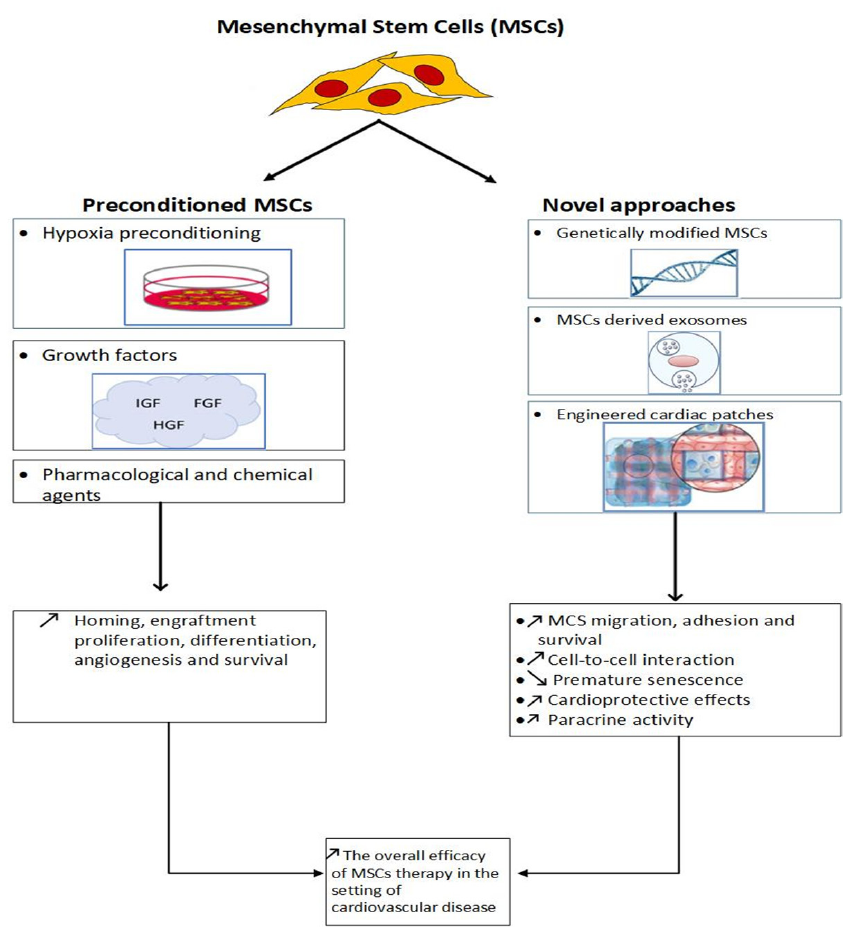
Figure 1. Figure illustrating mesenchymal stem cell (MSC) preconditioning methods, novel ap- proaches and their main impacts.